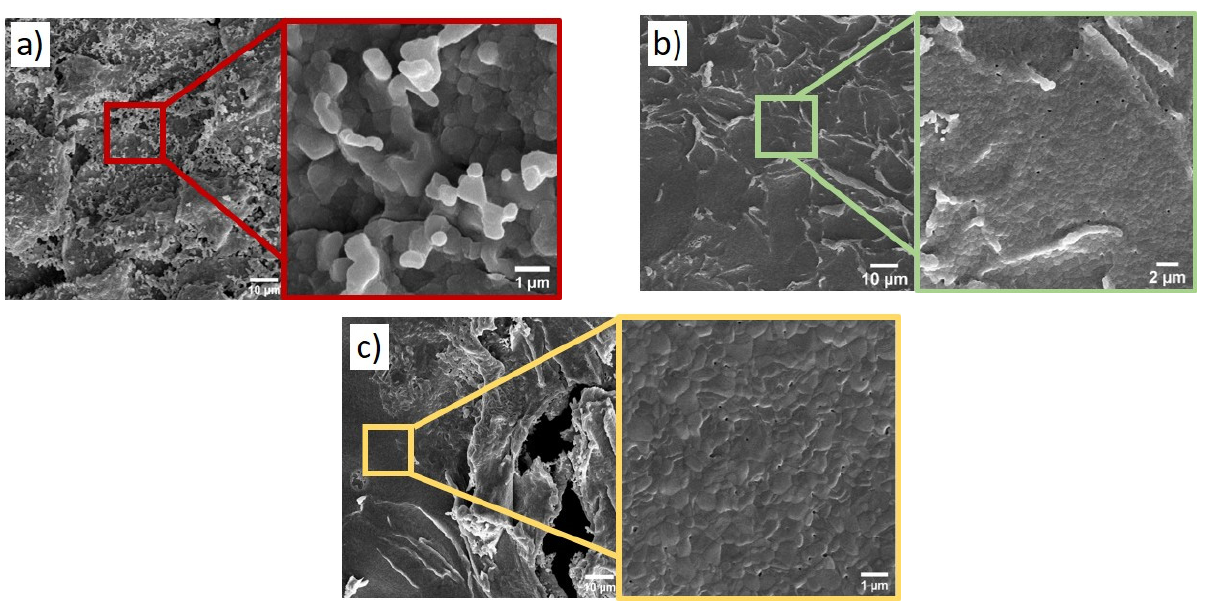
Figure 3. SEM micrographs of surface Al 2 O 3 /SrCO 3 xerogels with the 1.0 Sr molar ratio annealed at: ( a ) 1000 °C (1273K), ( b ) 1150 °C (1423K), and ( c ) 1300 °C (1573K).